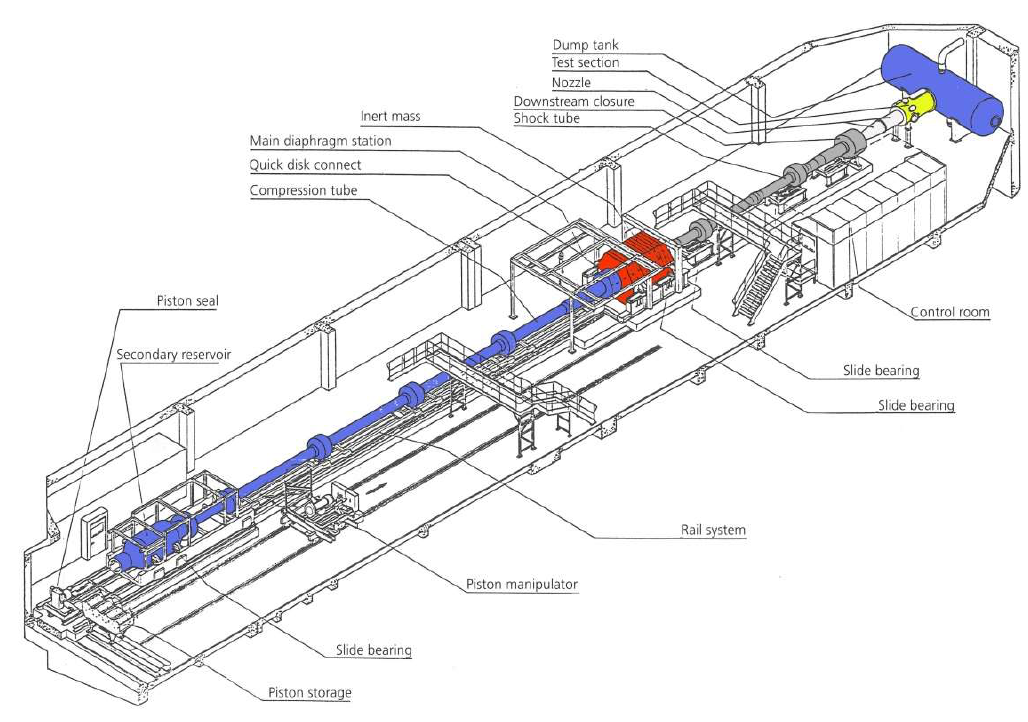
Figure 2: Schematic of the High Enthalpy Shock Tunnel Göttingen,